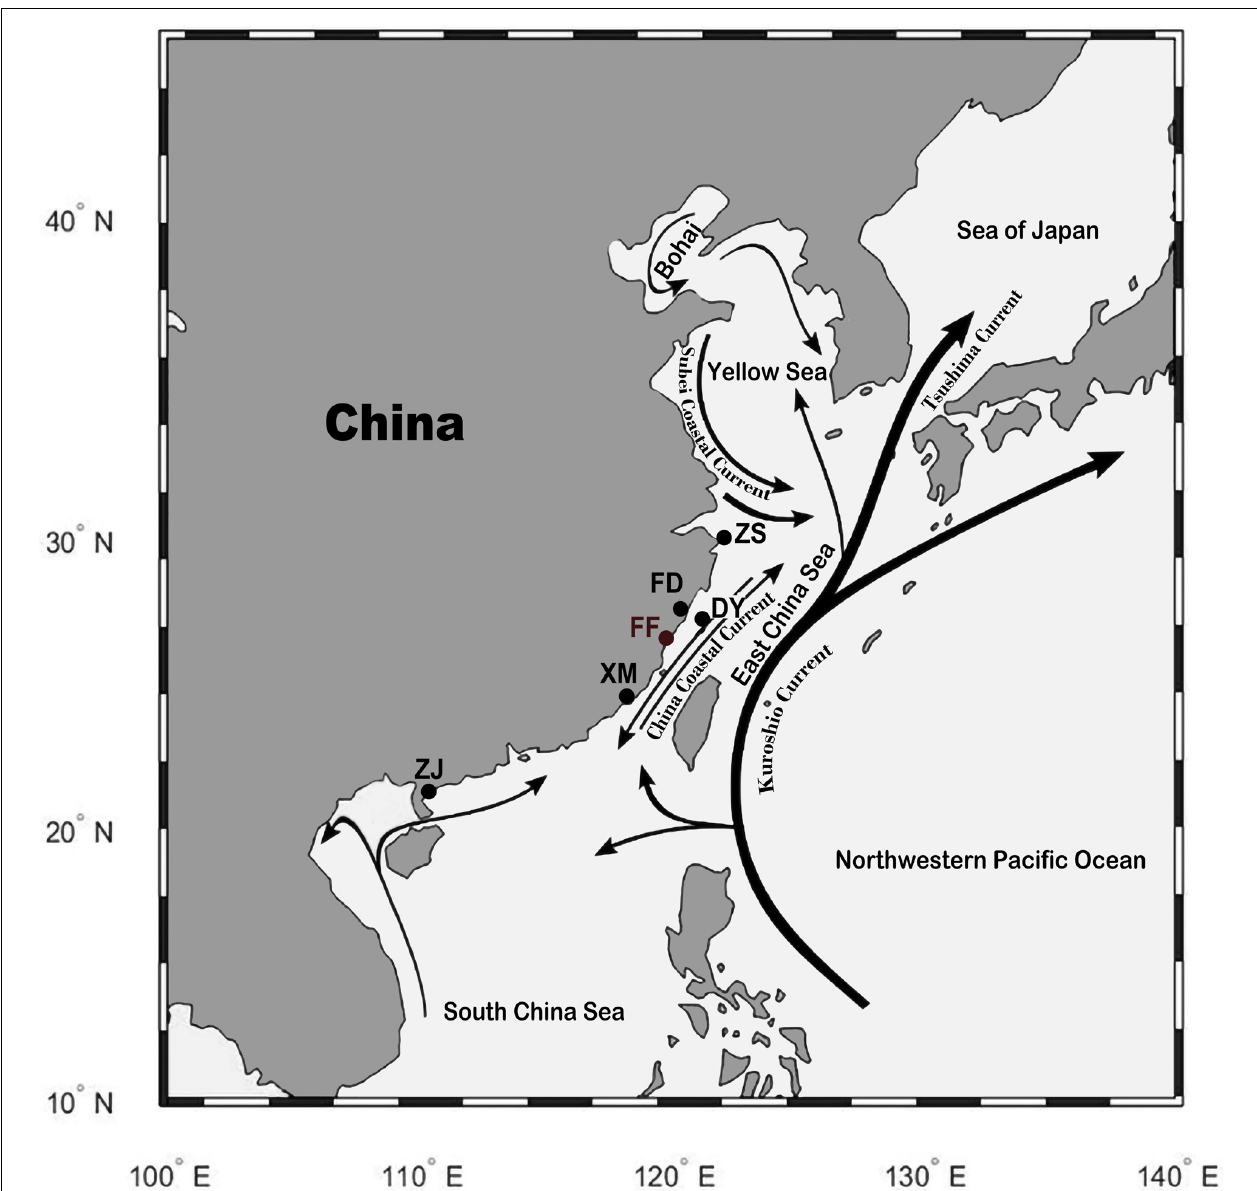
FIGURE 1 | Sampling location of the wild and cultured population of large yellow croakers. Wild population: ZS, Zhoushan; FD, Fuding; DY, Dayu; XM, Xiamen; ZJ, Zhanjiang. Cultured population: FF, Fufa. The black lines with an arrow indicate the current in the sea. The figure was generated by using the R package “ggmap” (author David